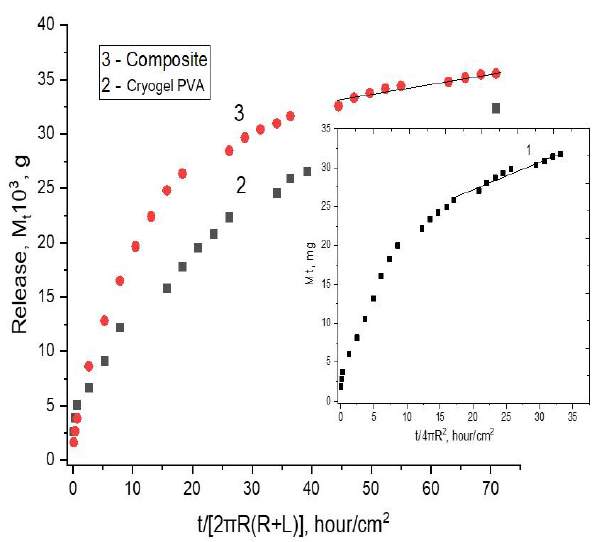
Figure 5. Kinetic profiles of SVN release from the drug-loaded PHB-microbeads (1), the non-filled PVA cryogel (2) and the composite cryogel as final product marked with a red colour (3).